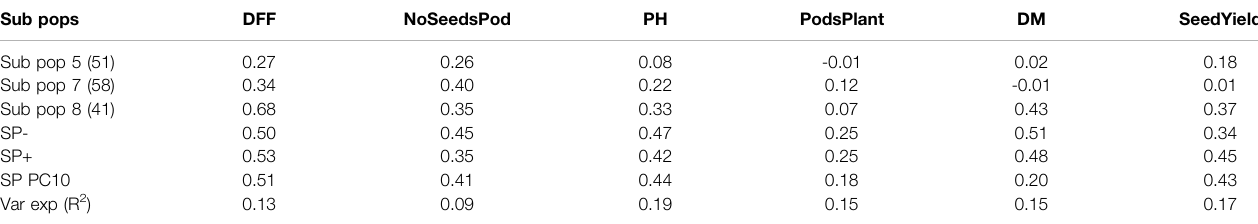
TABLE 3 | Predictive ability within and across subpopulations using RR-BLUP and all SNP markers.